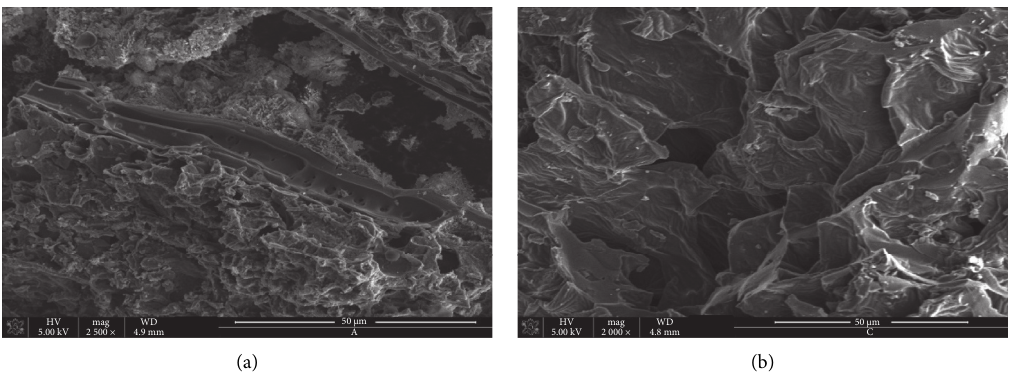
Figure 1: Scanning electron microscopy (SEM) images: (a) DPAC sorbent and (b) PPAC